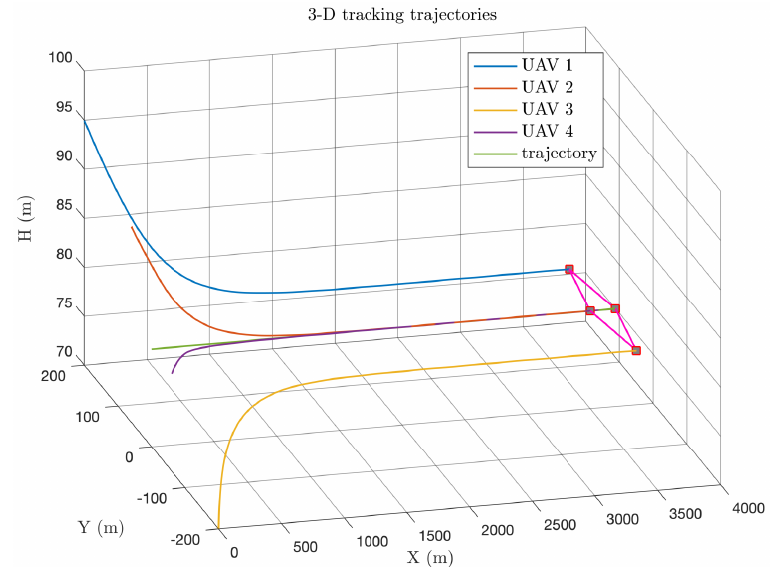
Figure 10. 3D tracking trajectories.